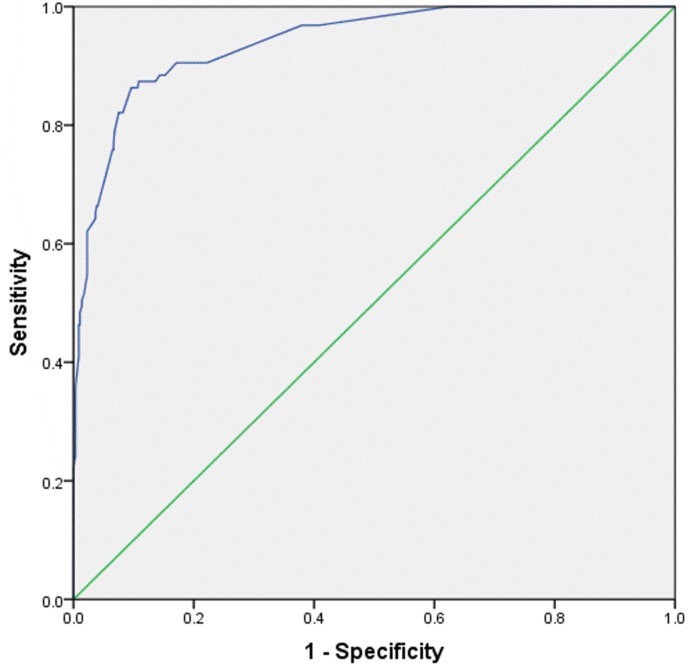
ROC Curve analysis of Multivariate regression model of AKI among dengue patients.